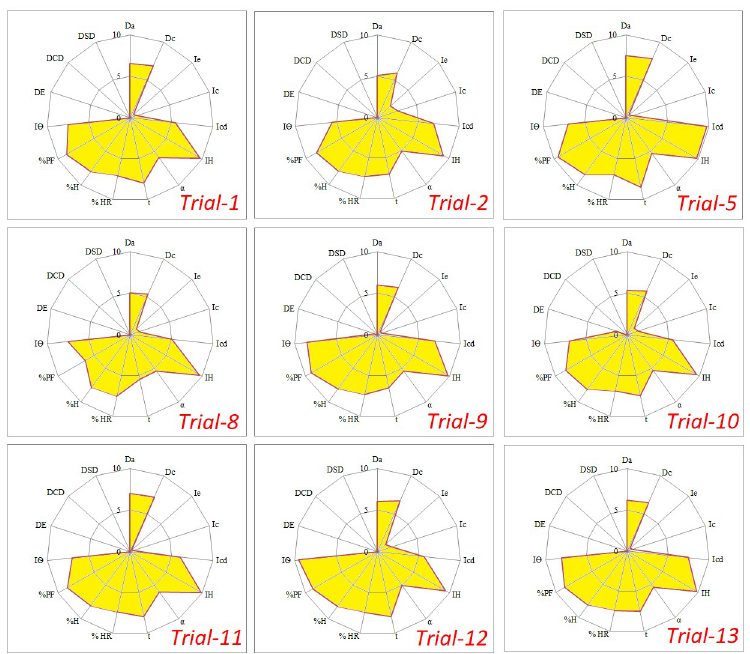
Fig 3. SeDeM-ODT diagrams of granules prepared under different levels of process variables (binder concentration and granulation time) by high shear wet granulation method.